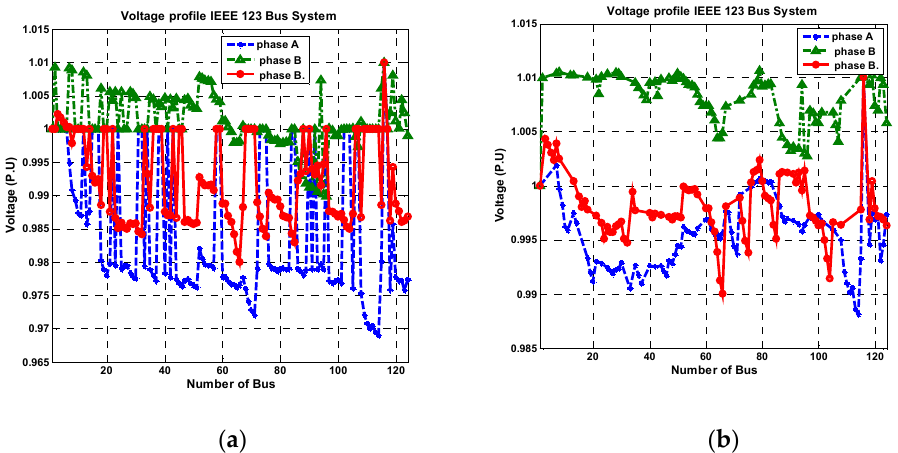
Figure 9. Voltage profile for three phases of the 123-node test unbalanced system: ( a ) Without DG via the proposed algorithm; ( b ) with DG via the proposed algorithm.